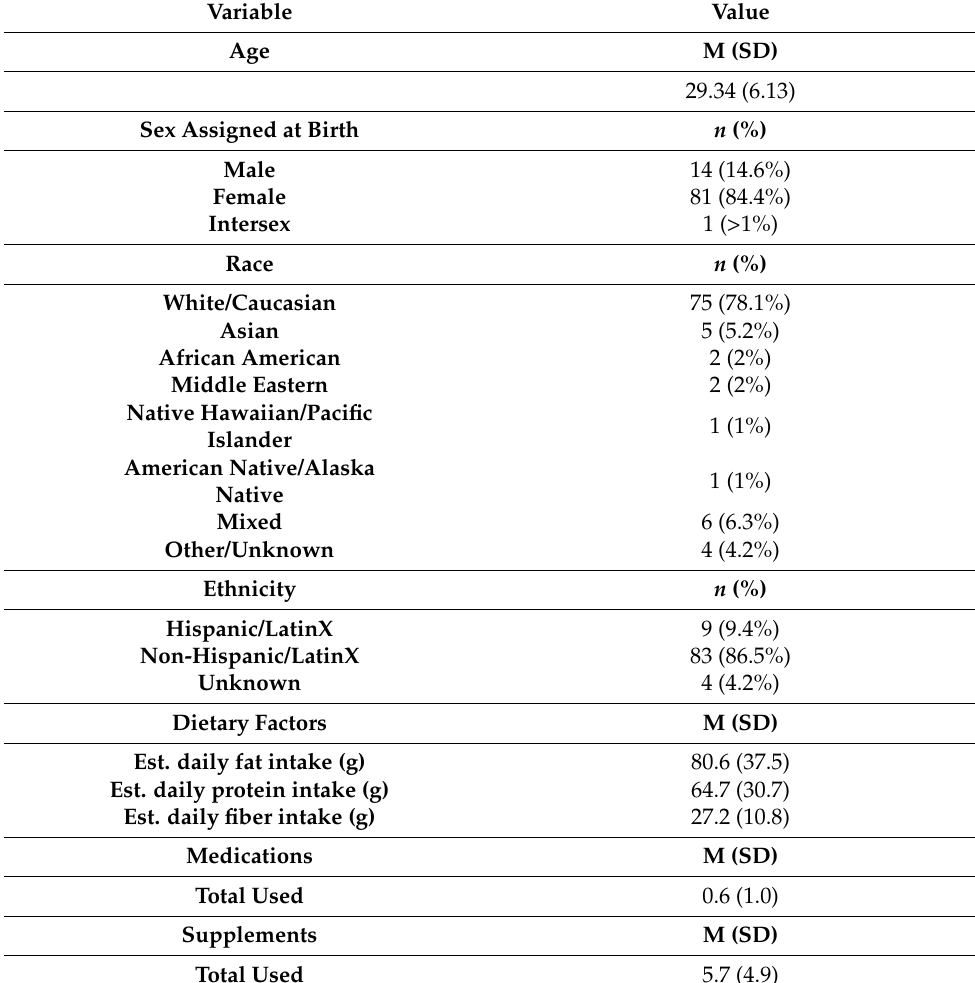
Table 2. Characteristics of study participants ( n =